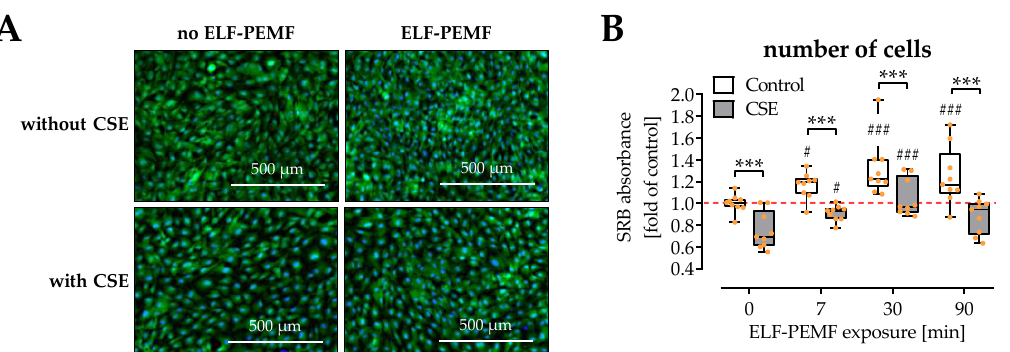
Figure 1. SCP-1 cell viability is affected by 16 Hz ELF-PEMFs (0, 7, 30, and 90 min) and 5% cigarette smoke extract (CSE). ( A ) Fluorescent Calcein-AM staining (2 µM, green) was used to visualize living cells, and Hoechst 33,342 (2 μg/mL, blue) was used as nuclear counterstain. ( B ) Sulforhodamine B (SRB) staining was used to quantify cell numbers by total protein content after 3 days. N = 3, n = 3. Data are presented as a box plot (Min to Max with single data points). Data were compared by non-parametric two-way ANOVA followed by Tukey’s multiple comparison test: *** p < 0.001 as indicated; # p < 0.05 ### p < 0.001 as compared to the respective control (no ELF-PEMF).